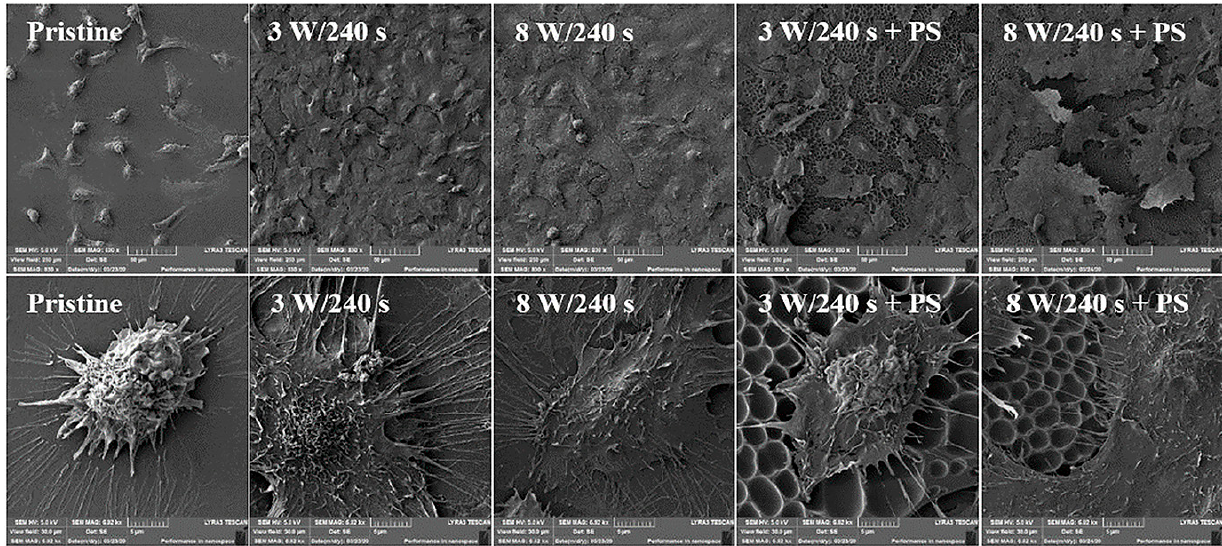
Figure 8. Scanning electron microscopy images of human osteoblasts (U-2 OS) six days post-seeding on FEP (pristine), FEP matrices treated by plasma with 3 W and 8 W (240 s) and subsequently coated with a honeycomb-like pattern formed from PS. The upper line represents a 250 × 250 µm 2 scan, the bottom line a detailed scan with the area of 30 × 30 µm 2 . [27].